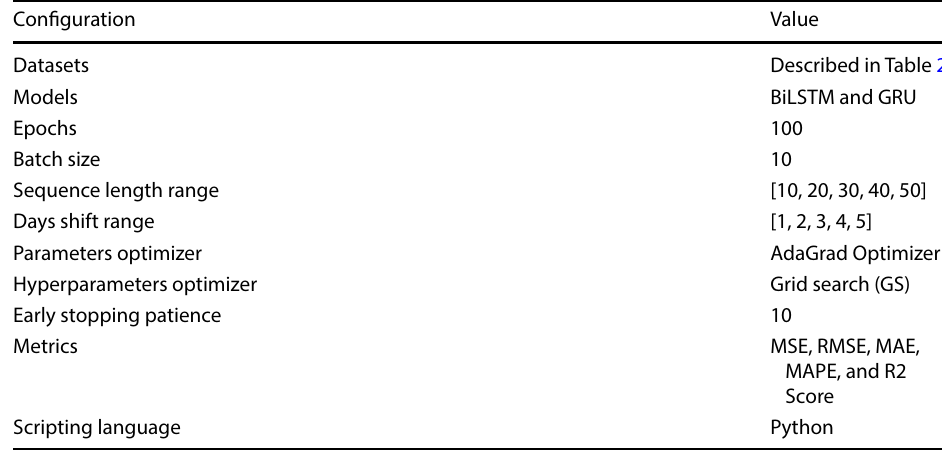
Table 4 The experiments’ configurations in the current